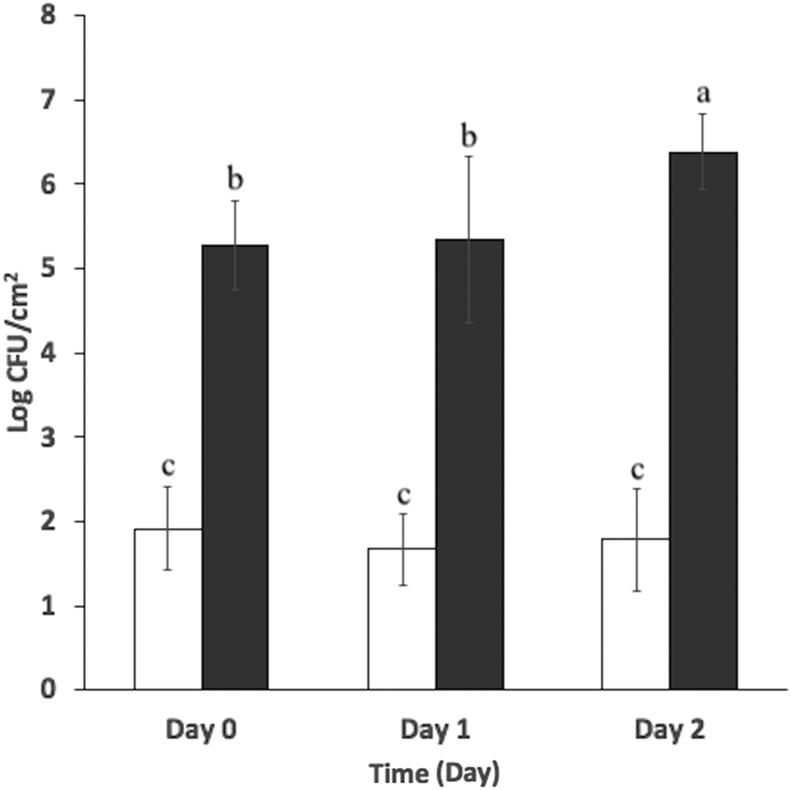
Total aerobic populations (log CFU/cm2) on Image 2: Romaine lettuce leaf and Image 3: cantaloupe tissues after 0, 1 and 2 days incubation at 8 ± 1 °C. Different superscripts (a–c) denote significant differences (P < 0.05) between aerobic populations on lettuce leaves and cantaloupe flesh across day 0, 1 and 2. Means and standard deviations were calculated using data from fourteen biological replicates. Limit of detection is > 0.36 log CFU/cm2.